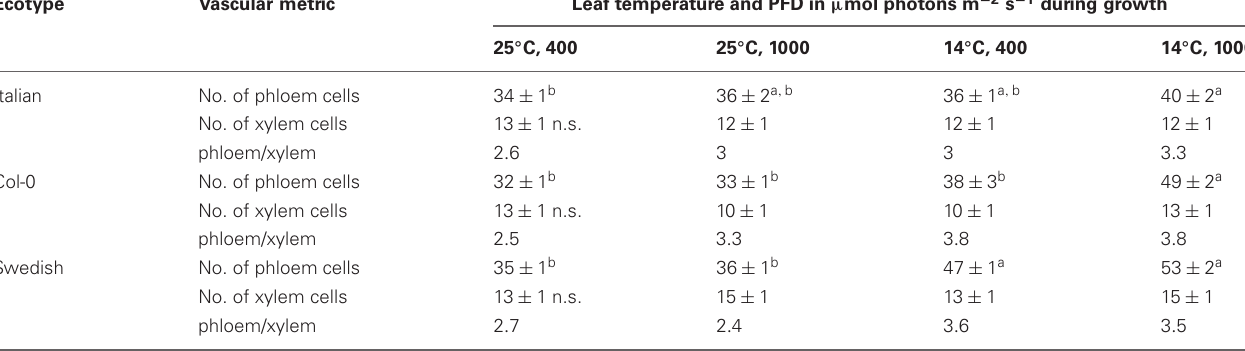
Table 1 | The total number of phloem cells, the total number of xylem cells, and the ratio of phloem cell number to xylem cell number per minor loading (third- and fourth-order) vein in leaves of the Italian, Col-0, and Swedish ecotypes of A. thaliana grown under four different temperature and PFD regimes.